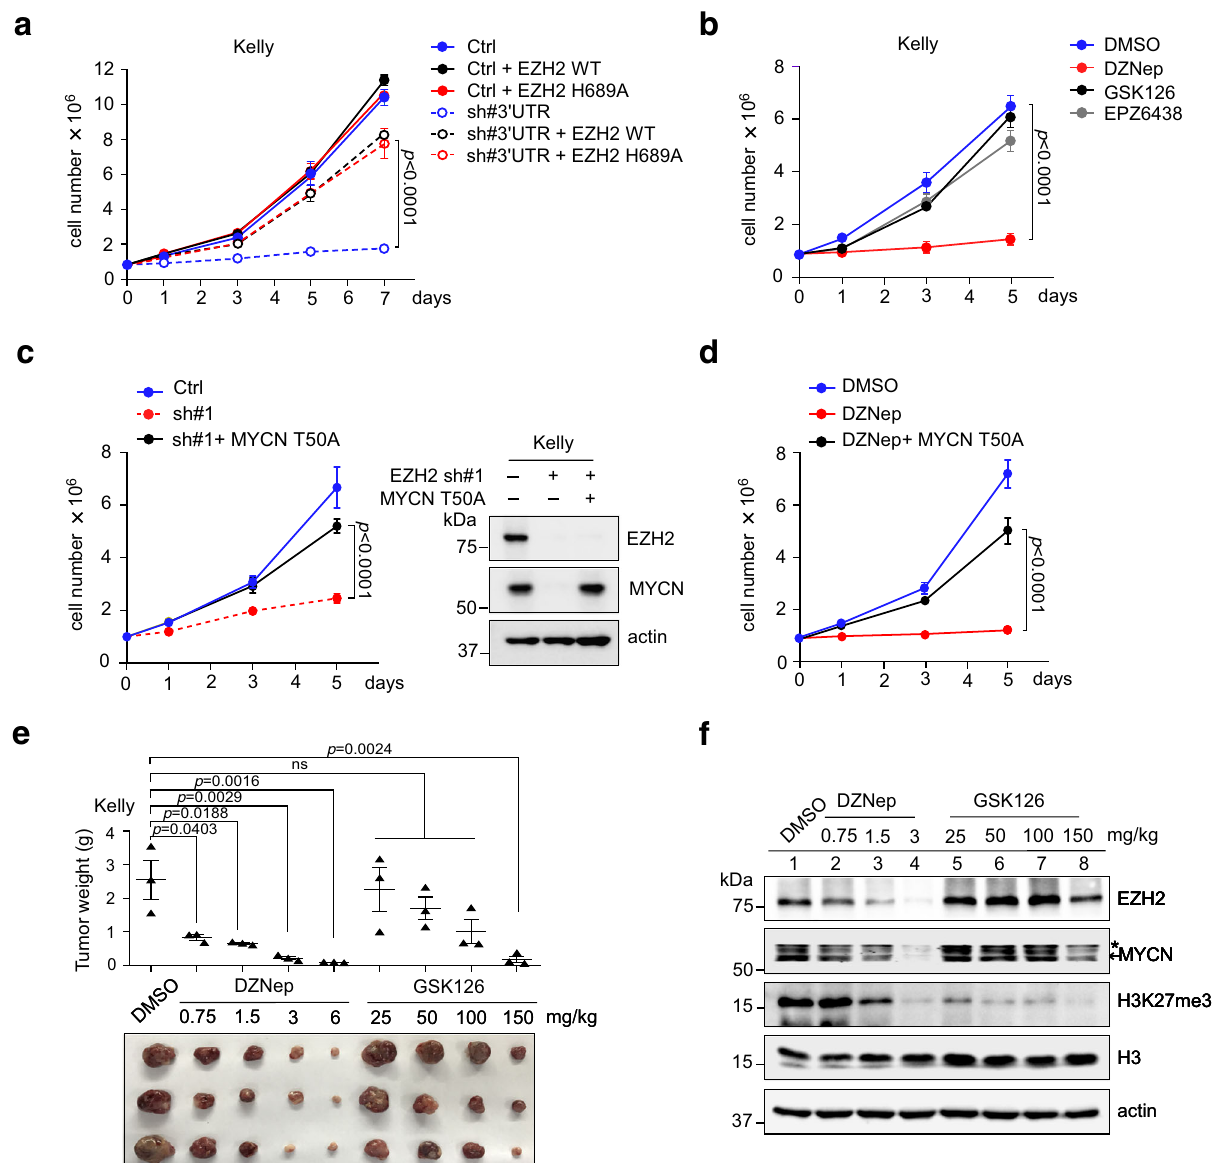
Fig. 5 Depletion of EZH2, but not enzymatic inhibition, inhibits tumor cell growth in a MYCN-dependent manner. a Proliferation of Kelly cells was measured by serial cell counts upon shRNA depletion of endogenous EZH2 in the presence or absence of ectopically expressed EZH2 WT or H689A. Data shown were obtained from averages (±SD) of technical triplicates; signi fi cance was determined by two-way ANOVA test followed by Tukey ’ s correction. b Proliferation of Kelly cells was measured upon administration of 5 μ M of DZNep, GSK126, or EPZ6438. Data shown were obtained from averages (±SD) of technical triplicates; signi fi cance was determined by two-way ANOVA test followed by Tukey ’ s correction. c Proliferation of Kelly cells was measured upon shRNA depletion of endogenous EZH2 with or without ectopic expression of the MYCN T50A. Data shown were obtained from averages (±SD) of technical triplicates; signi fi cance was determined by two-way ANOVA test followed by Tukey ’ s correction. d Proliferation of Kelly cells was measured upon DZNep treatment (5 μ M) with or without ectopic expression of the MYCN T50A. Data shown were obtained from averages (±SD) of technical triplicates; signi fi cance was determined by two-way ANOVA test followed by Tukey ’ s correction. e Kelly xenografts were subjected to DZNep or GSK126 treatments at the indicated doses. Images of subcutaneous tumors ( n = 3 per group) under various treatments are shown. Graph shows mean ± SD from biological triplicates; signi fi cance was determined by one-way ANOVA test followed by Tukey ’ s correction. f Immunoblots of indicated proteins in Kelly xenograft tumors. The experiments were independently repeated three times with similar results. Source data are provided as a Source data fi